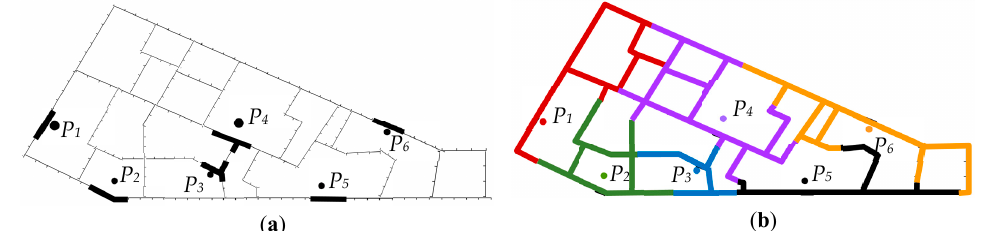
Figure 5. Process of dilation operation: ( a ) result after the first dilation operation and ( b ) result after the dilation operation is finished.